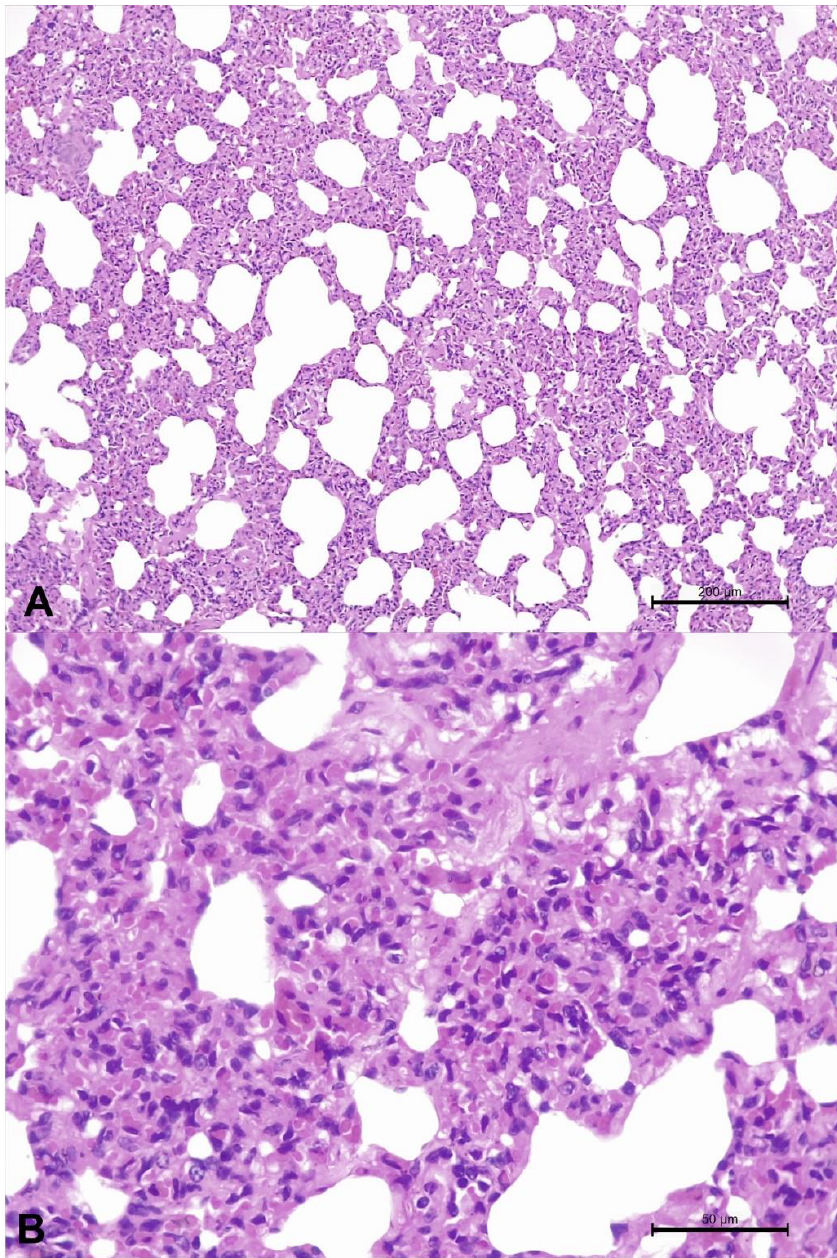
Figure 1. Histopathologic findings observed in a cow infected by bovine gammaherpesvirus 6. There is interstitial pneumonia ( A ) and a closer view demonstrates the thickening of alveolar walls without accumulation of exudate within the alveoli ( B ). Hematoxylin and eosin stain. Bars, ( A ) 200 µm; ( B ) 50 µm.